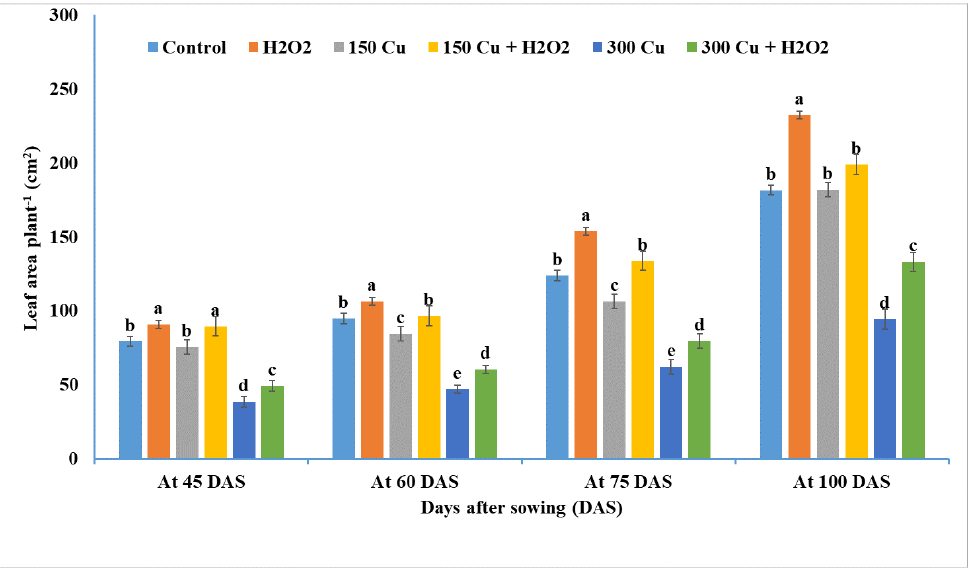
Figure 2. Effects of hydrogen peroxide on leaf area per plant at 45, 60, 75, and 100 DAS of wheat grown in copper contaminated sandy soil. Means followed by the same letter at each sampling date are not significantly different according to the least significant differences (LSD) test ( p ≤ 0.05). Error bars are ± Standard Error